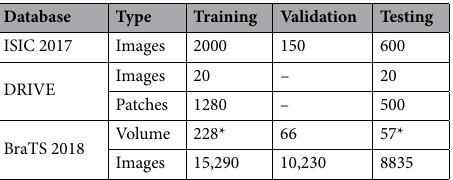
Table 1. Distribution of the three medical imaging databases. ‘*’ Indicates to the local training and testing sets of the BraTS 2018